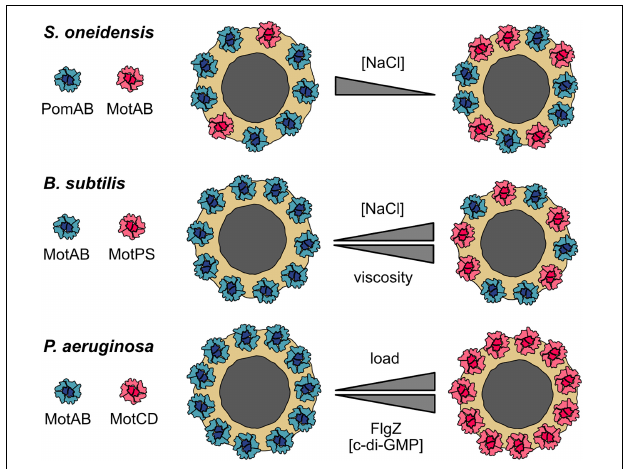
FIGURE 2 | Stator dynamics and dual stator systems. Cartoons of top views of the MS-ring and C-ring (gray and yellow, respectively) with the surrounding stator units. Upper panel: S. oneidensis possesses two types of stator units: Na + -dependent PomAB (blue) and H + -dependent MotAB (red). A low environmental concentration of Na + favors disengagement of PomAB from the motor and engagement of MotAB. At low Na + concentrations, the motor runs as a hybrid, synchronously using Na + and H + to drive rotation. The gray triangle indicates an increasing or decreasing concentration of the coupling ion Na + . Middle panel: a similar motor–stator arrangement is present in B. subtilis , which also has H + -dependent MotAB (blue) and Na + -dependent MotPS (red) stators. The MotAB stator is dominant under most conditions, but increasing concentrations of Na + and higher loads favor the incorporation of MotPS into the active stator ring. The upper triangle represents differences in the environmental Na + concentration, the lower triangle increase or decrease in environmental viscosity. Lower panel: P. aeruginosa has two H + -dependent individual stator units, MotAB (blue) and MotCD (red). MotAB powers rotation during planktonic free swimming, whereas MotCD is used under conditions of high load, e.g., during swarming across surfaces (indicated by the upper gray triangle). It should be noted that it is not clear if all MotAB stators are replaced. Notably, the regulator of the flagellar motor, FlgZ, when it is binds the secondary messenger c-di-GMP, uncouples MotCD (but not MotAB) from the motor (indicated by the lower gray triangle). MotCD then interacts with the membrane-localized diguanylate cyclase SadC to stimulate production of more c-di-GMP. Thus, at high c-di-GMP concentrations, cells of P. aeruginosa are unlikely to induce swarming but rather remain associated tightly with the surface (see the main text for